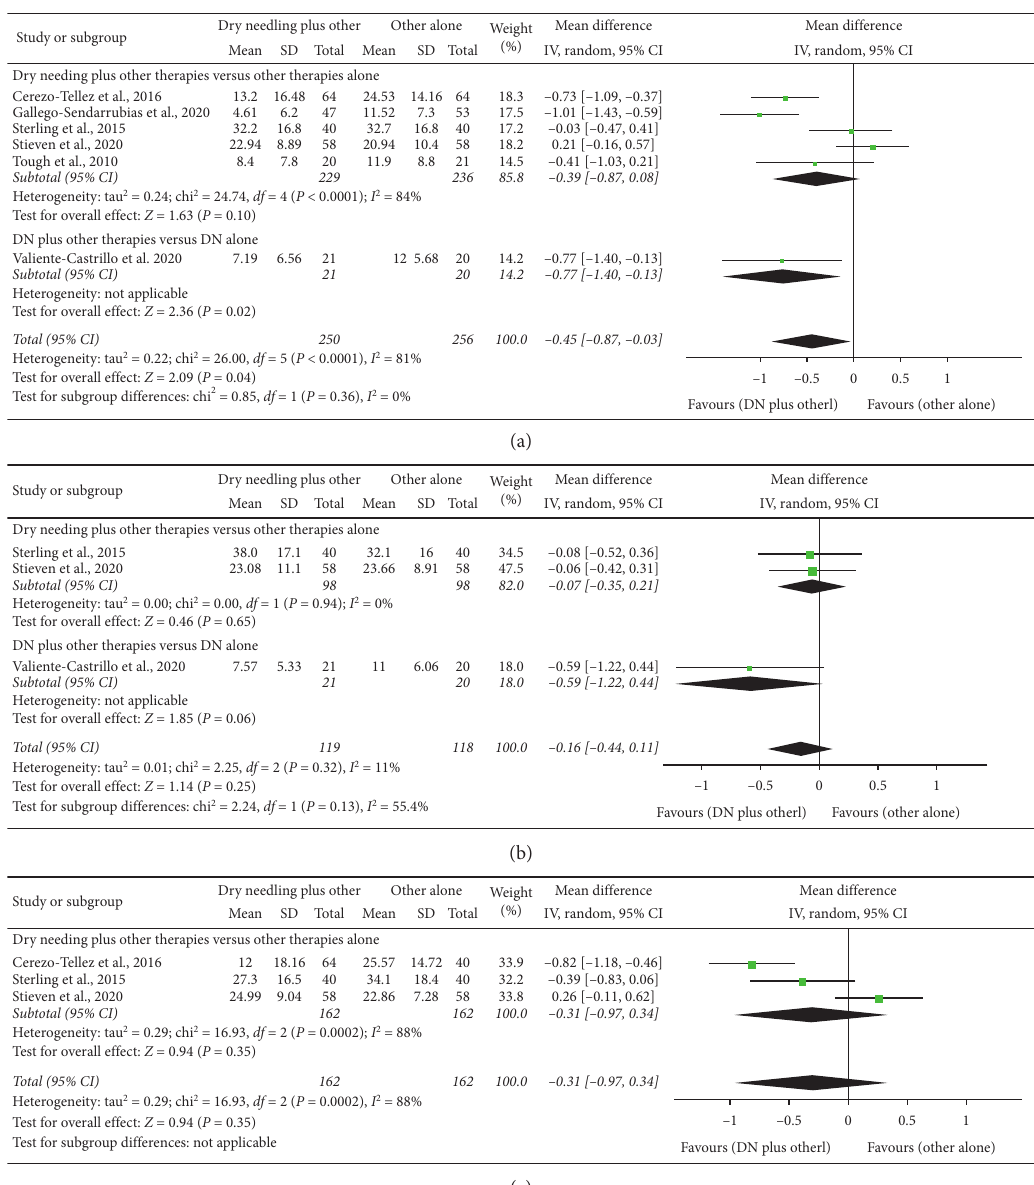
Figure 4: Comparison (standardized mean differences) between the effects of dry needling combined with other interventions against other interventions on pain-related disability (a) at short-term, (b) at midterm, and (c) at